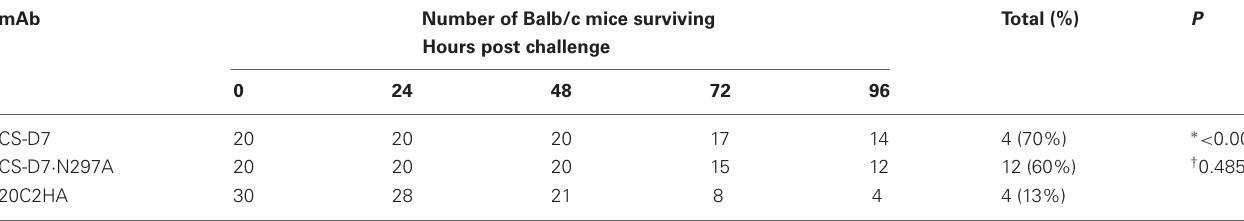
∗ Comparison of survival with CS-D7 versus survival with isotype control 20C2HA. † Comparison of survival with CS-D7 · N297A versus survival with CS-D7. Table 3 | Passive immunization and challenge of Fc γ RIII − / − mice. mAb